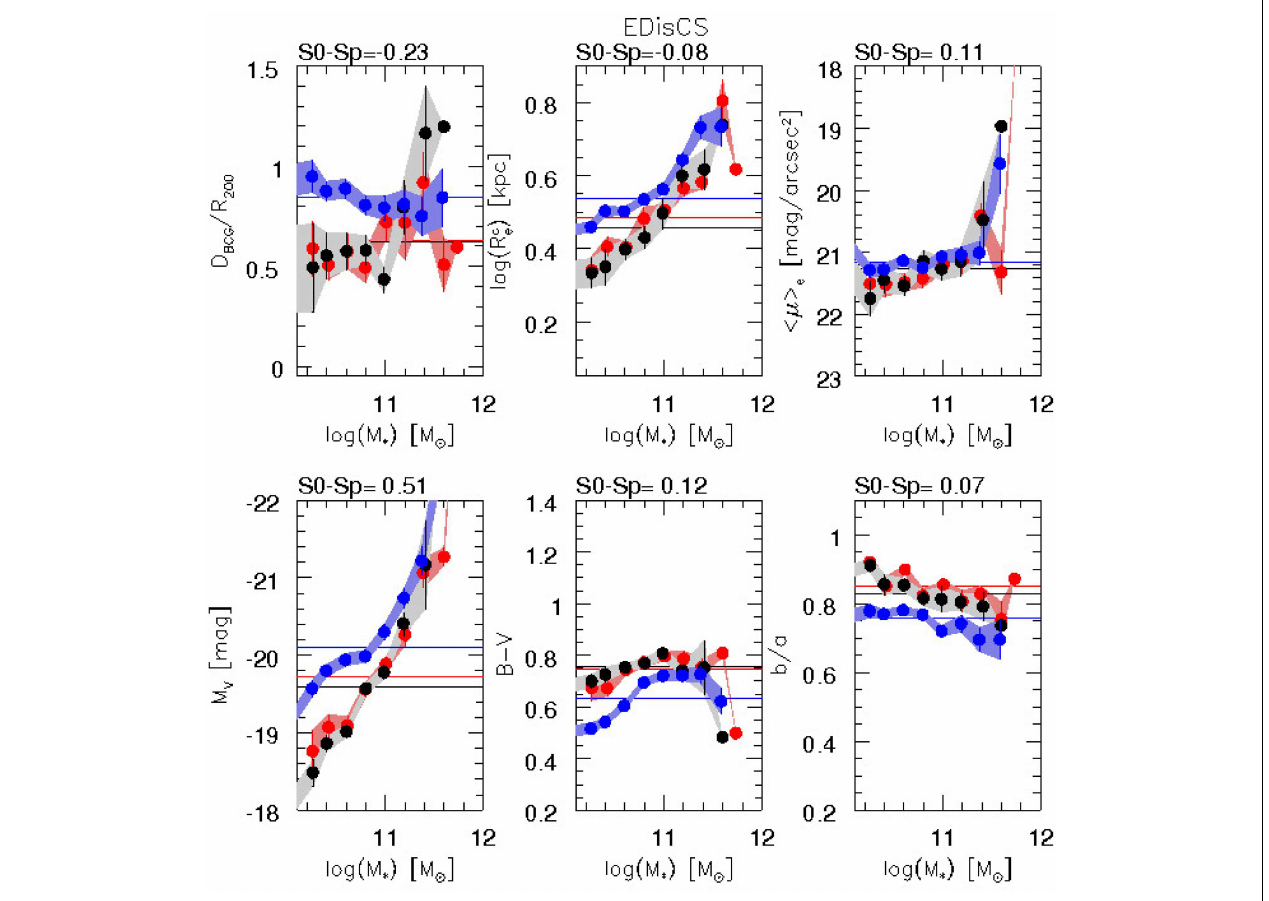
FIGURE 11 | The same trends as a function of galaxy